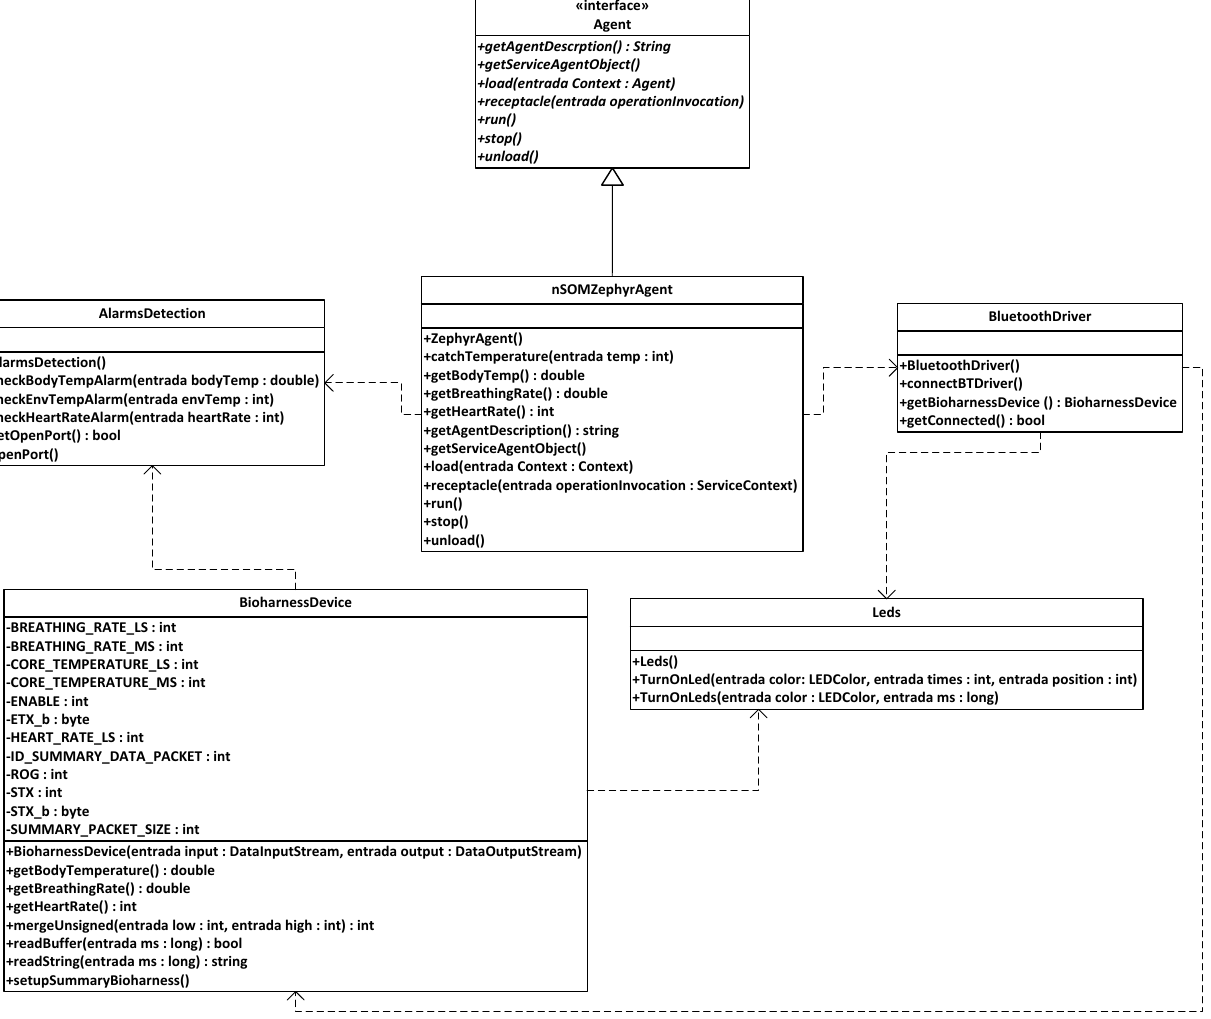
Figure 19. Interrelating class diagrams of Zephyr and alarm